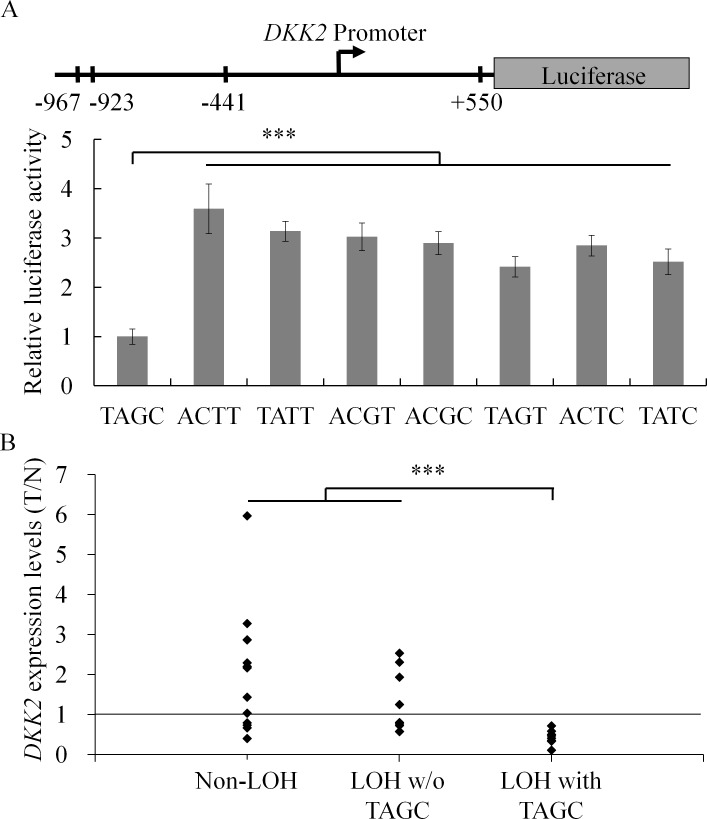
DKK2 expression is down-regulated in tumor tissues with chromosome 4q24-25 LOH and DKK2 TAGC haplotype.(A) Luciferase activity of the various DKK2 haplotypes in HuH-7 cells. A reporter assay was performed to test the sequences that cover the DKK2 promoter region from 1,135 bp upstream to 667 bp downstream of the transcription initiation site. The coding sequence of the luciferase was fused to the DKK2 promoter and 5’UTR sequence. The promoter function of each DKK2 haplotype sequence was assessed using luciferase activity, and the data obtained was normalized against the expression level of the cotransfected β-galasctosidase gene. The position of the four SNPs (at -967, -923, -441, and +550) is shown relative to the transcription initiation site. The promoter activity of the TAGC haplotype was significantly reduced relative to the other haplotypes. No significant effect on cell viability post transfection was observed for the reporter plasmids containing different DKK2 haplotypes. (B) Relative DKK2 mRNA expression levels of the tumor (T) tissues and the non-tumor (N) counterparts (n = 30) were assayed by RT-qPCR and classified into three categories determined by the presence of chromosome 4q24-25 LOH and/or DKK2 TAGC haplotype. The group with chromosome 4q24-25 LOH and DKK2 TAGC haplotype (LOH with TAGC, n = 8) showed significantly lower DKK2 expression in tumor tissue than the other two groups: without chromosome 4q24-25 LOH (non-LOH, n = 13) and with chromosome 4q24-25 LOH but no DKK2 TAGC haplotype (LOH w/o TAGC, n = 9). *** p < 0.001